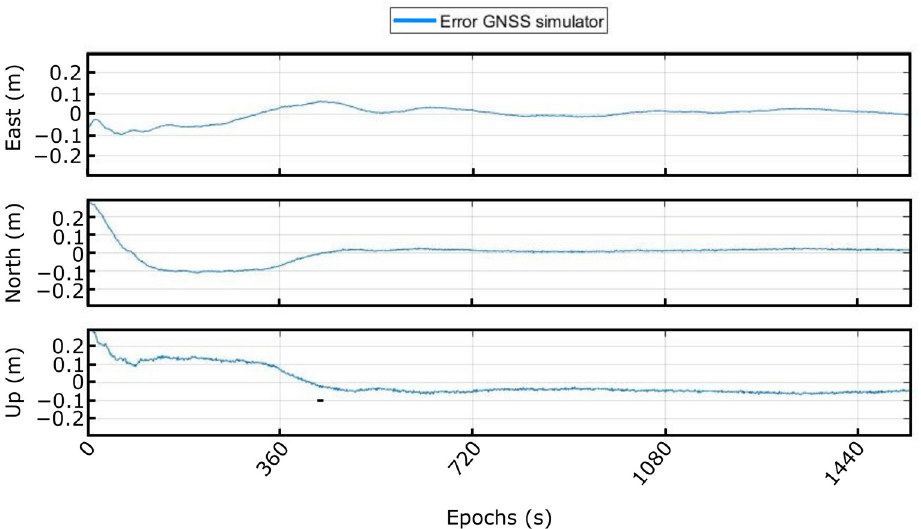
Figure 12. Solution error achieved in the GNSS